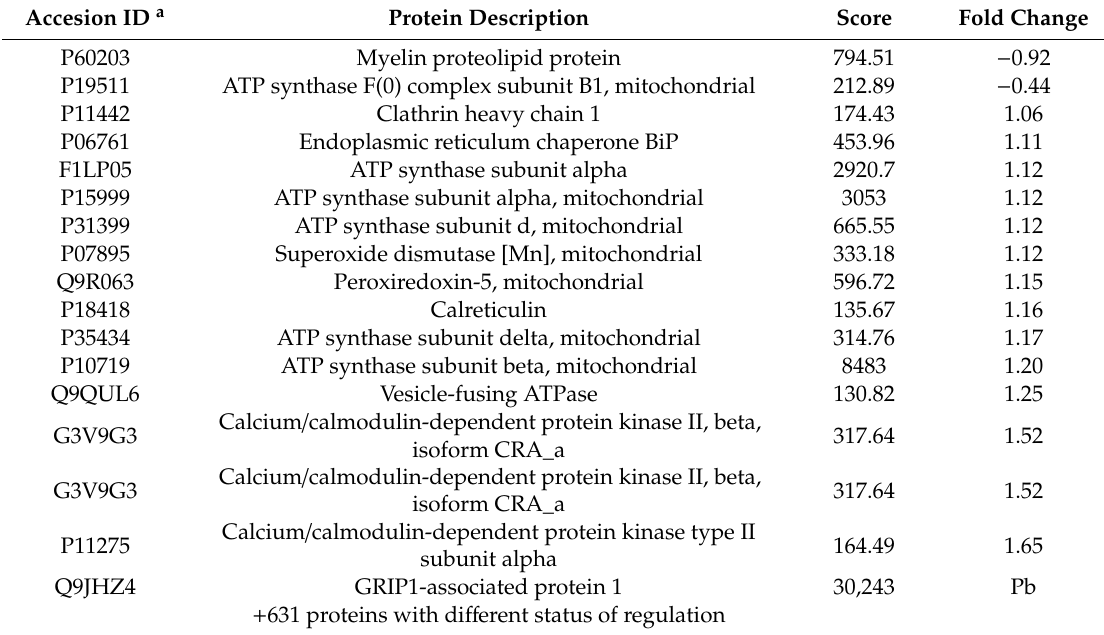
Table 1. Highlighted proteins found in the proteome of rats cerebellum exposed to lead acetate in comparison to